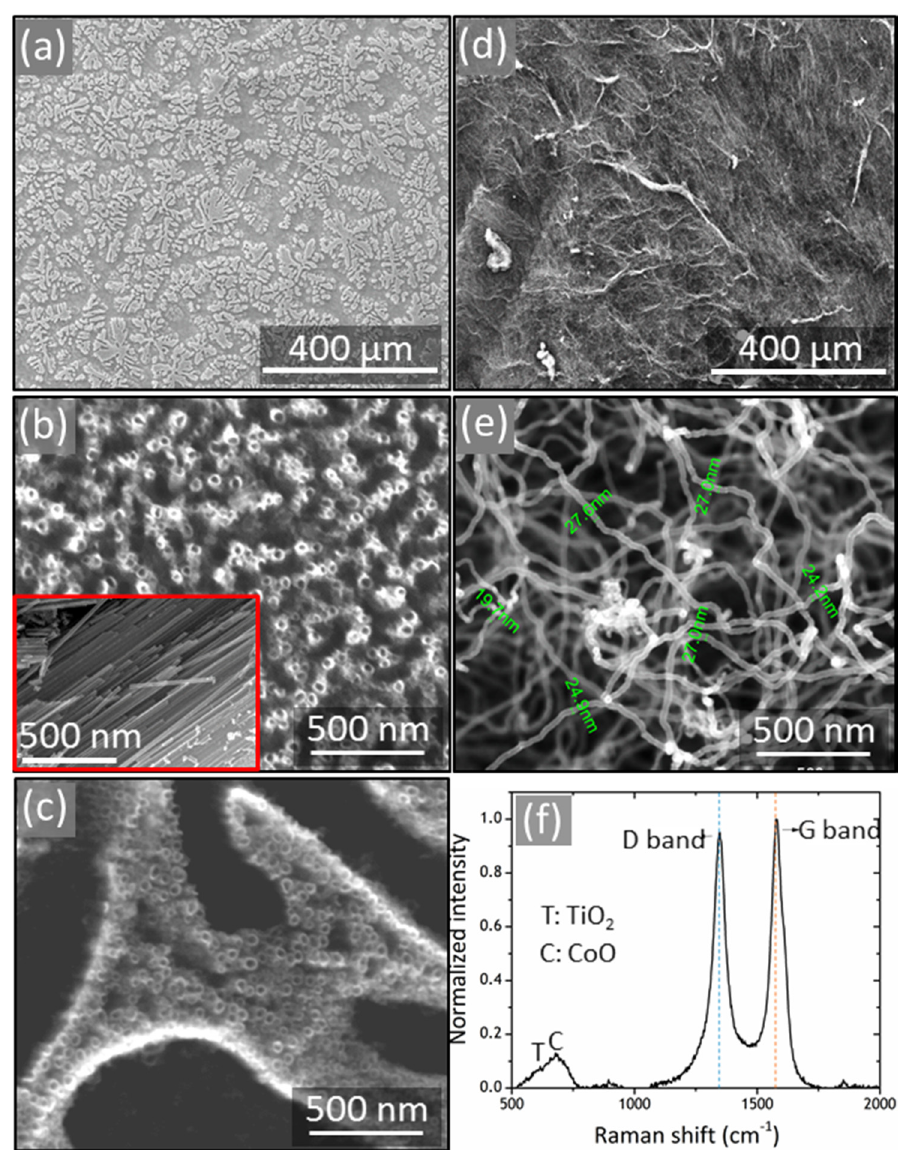
Figure 2. SEM micrographs, an overview of anodized Ti-Co alloy ( a ); high magnification of the β -Ti ( b ) and the Ti 2 Co ( c ) phases anodized at 60 V; low ( d ) and high ( e ) magnifications of the ternary CNTs@TiO 2 /CoO NTs; and Raman spectra of ternary CNTs@TiO 2 /CoO NTs ( f ).